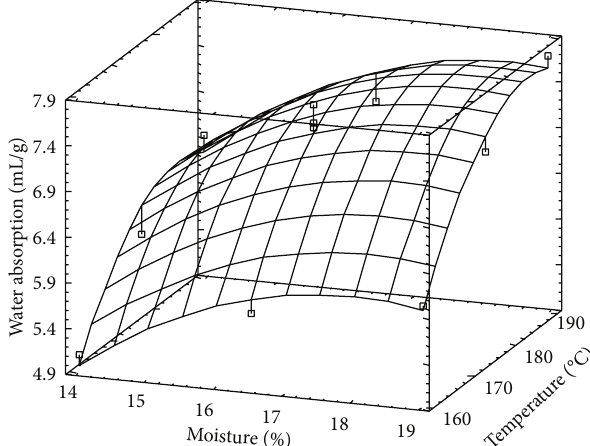
Figure 4: Surface response for water absorption corresponding to Fortuna rice variety.